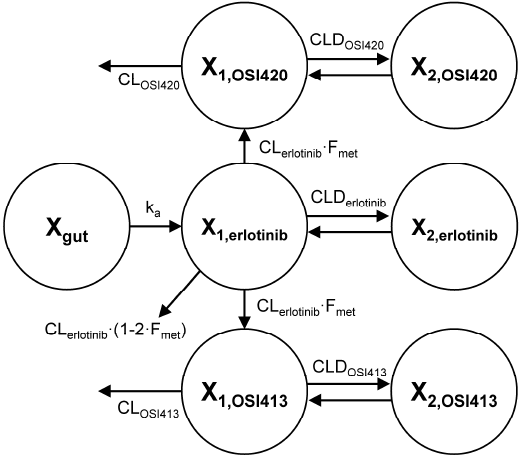
Figure 3. Structural model for the absorption and disposition of erlotinib and its active metabolites, OSI ‐ 420 and OSI ‐ 413 in rats.